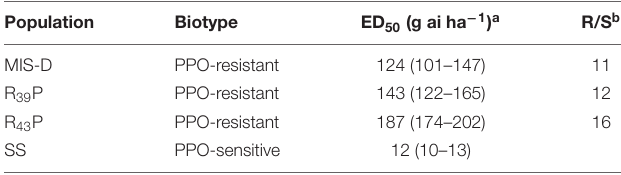
TABLE 1 | Resistance levels of protoporphyrinogen oxidase-resistant Amaranthus palmeri populations.